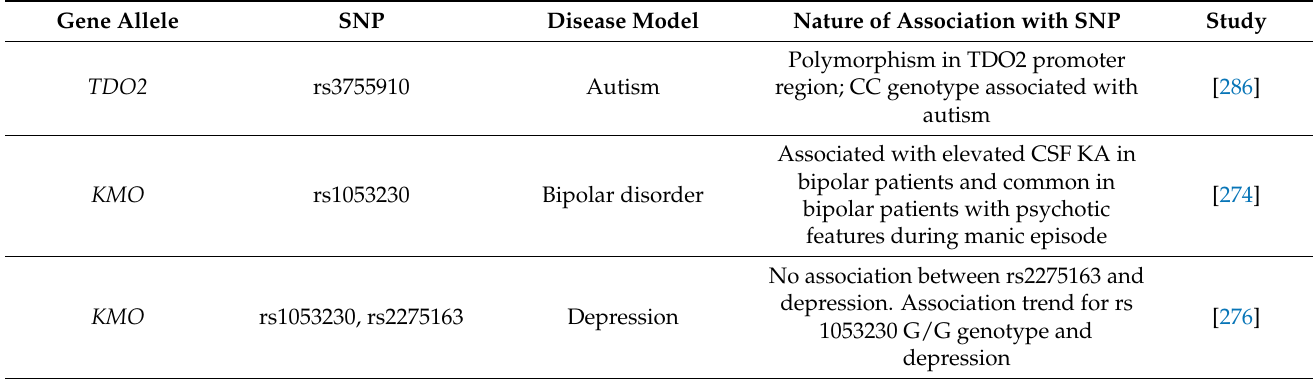
Table 3. Single Nucleotide Polymorphisms found in the Enzymes involved in KP metabolism associated with CNS diseases. Recent genome wide studies have discovered SNP’s on KP metabolism genes that co-relate with patient symptom severity and treatment outcome. These critical associations will aid in understanding genetic risk, susceptibility and vulnerabilities factors in conjunction to developing animal models, tools and novel therapeutic strategies to target KP metabolism for CNS